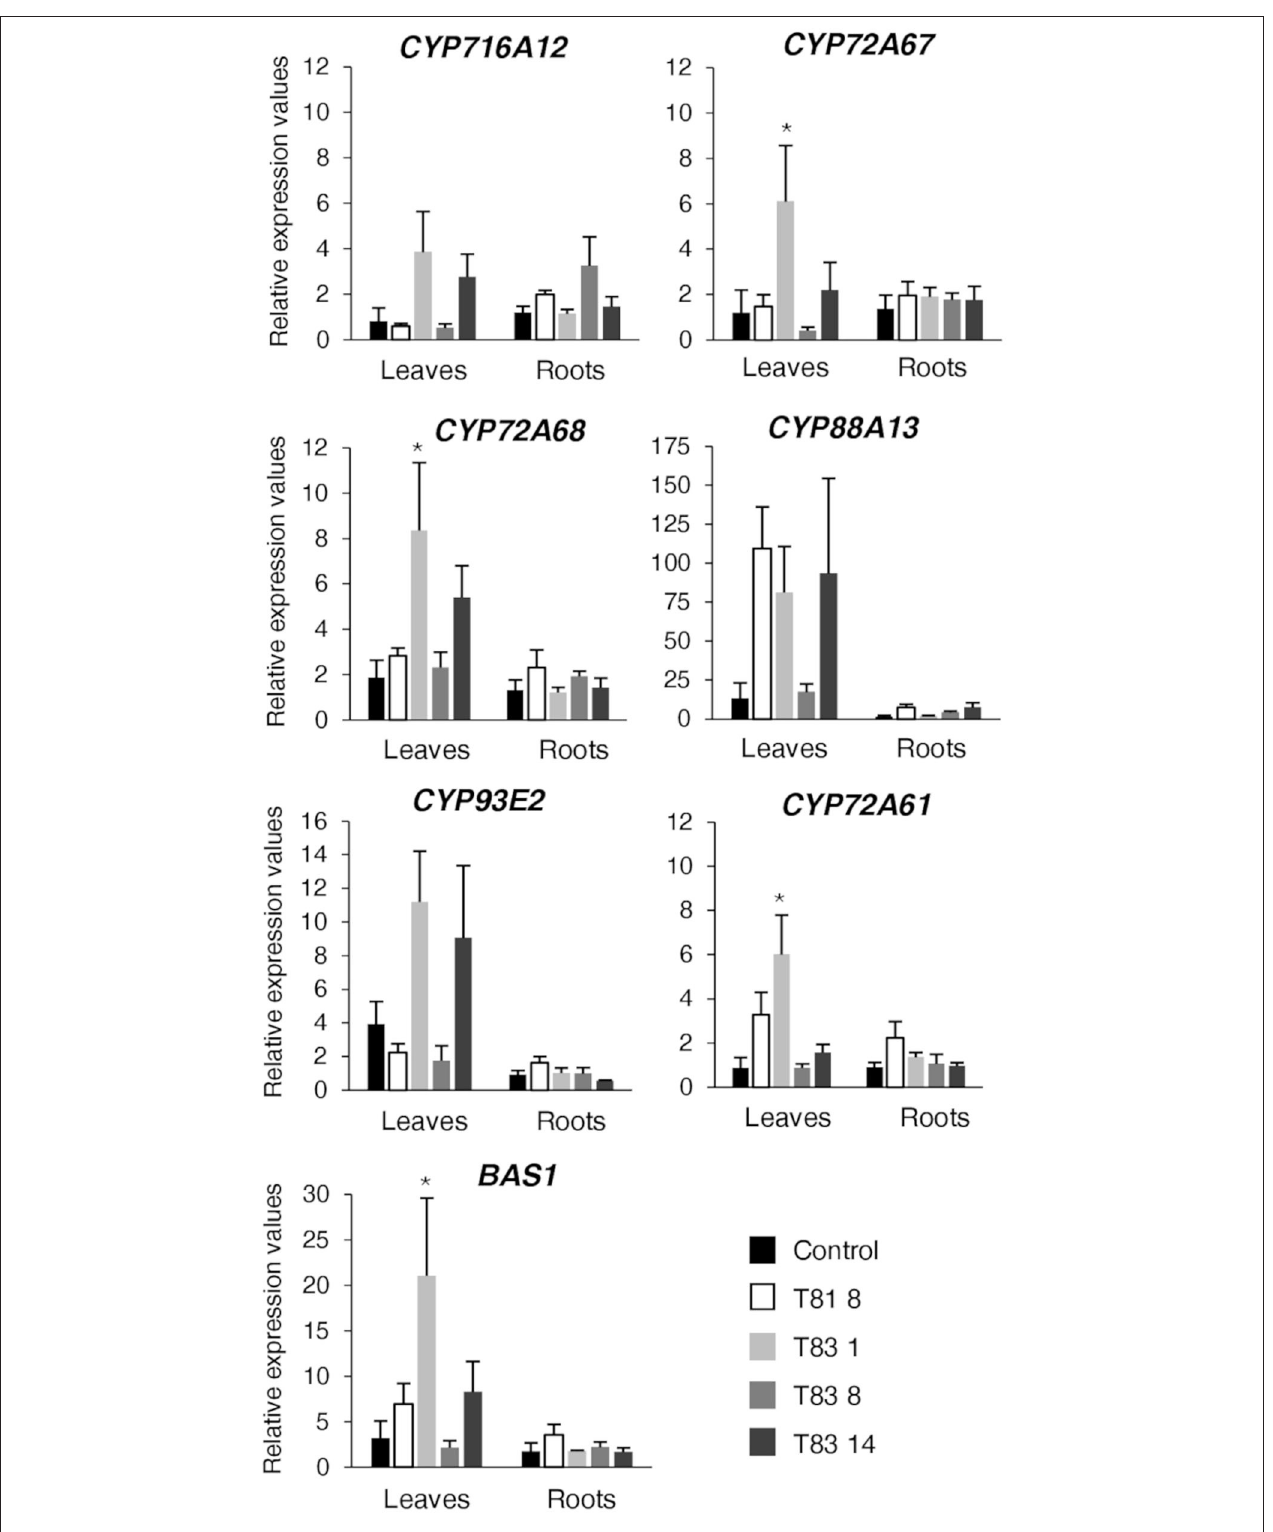
FIGURE 5 | Expression analysis using quantitative RT-PCR on sapogenin pathway genes. Values were calculated by the comparative Ct (cycle threshold) method using roots of control line as reference. Values are means ± SE of four biological replicates. An asterisk indicates means significantly different from control according to Dunnett’s Test ( p <